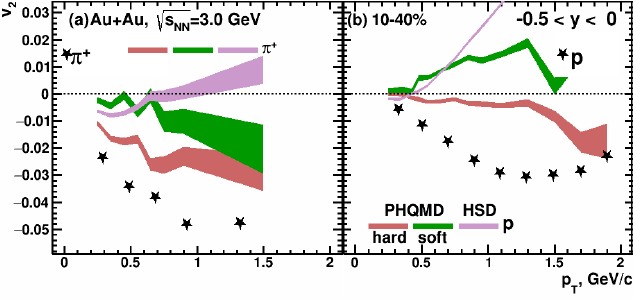
Figure 13. p T dependence of elliptic flow v 2 of pions ( a ) and protons ( b ) in 10–40% central Au + Au √ s NN = 3.0 GeV. The symbols denote the published data from the STAR experiment [15]. collisions at The red and green bands represent the results from PHQMD model with hard ( K 0 = 380 MeV) and soft ( K 0 = 200 MeV) EOS, respectively. The purple bands represent the results from the HSD model. The uncertainties of the simulated model data are statistical.